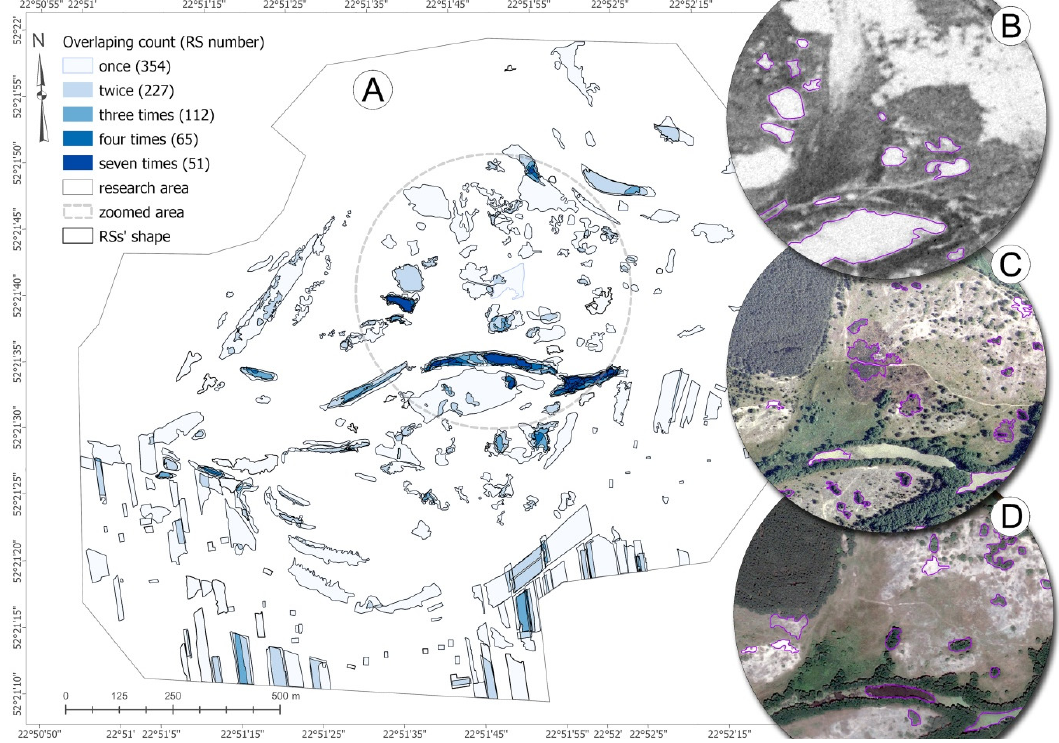
Figure 5. Digitized reference segments (RSs) and their overlapping count across the whole research area ( A ), and RS examples for ( B ) 1965, ( C ) 2006, and ( D ) 2015.